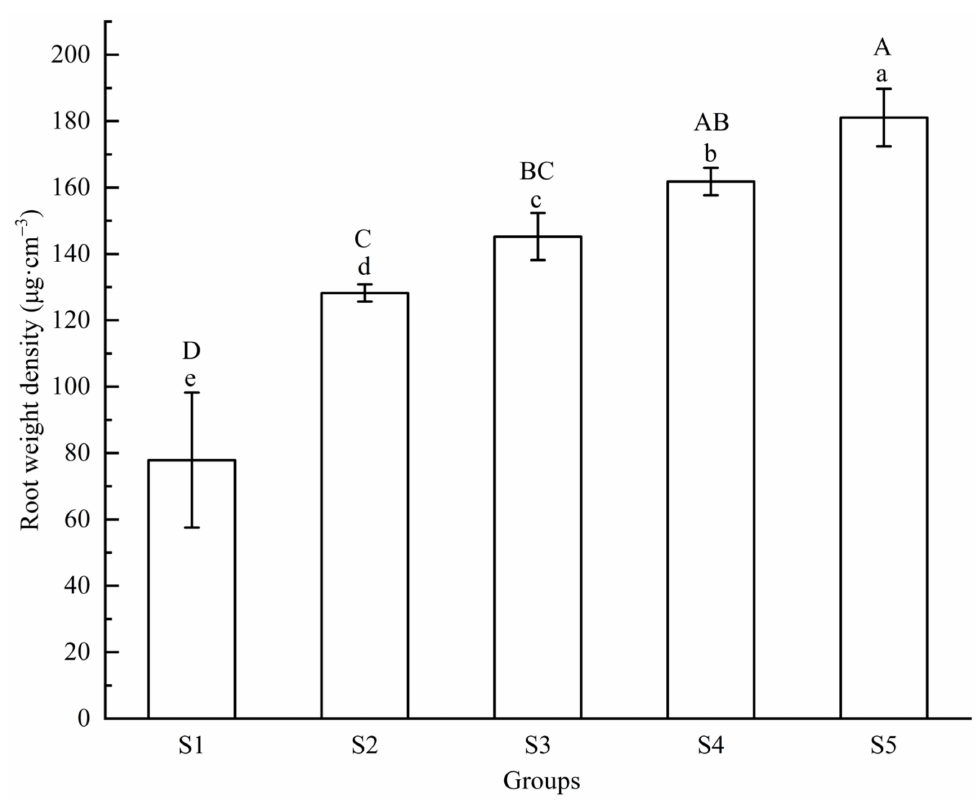
Figure 5. The okra root weight density in different groups. Different lowercase letters indicate signifi- cant differences among treatments at p < 0.05, while different uppercase letters indicate significant differences among treatments at p <